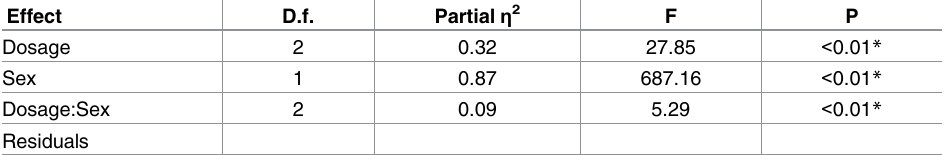
Table 2. Randomization ANOVA results for the response variable of wing length and the explanatory variables of sex and parasite dosage.